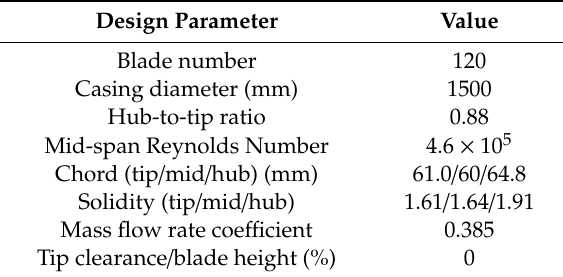
Figure 3. Geometric parameters and measuring equipment: ( a ) stator lean and leading and trailing blade angle; ( b ) probes and displacement mechanism. Table 1. General specifications of the low-speed axial compressor stator.